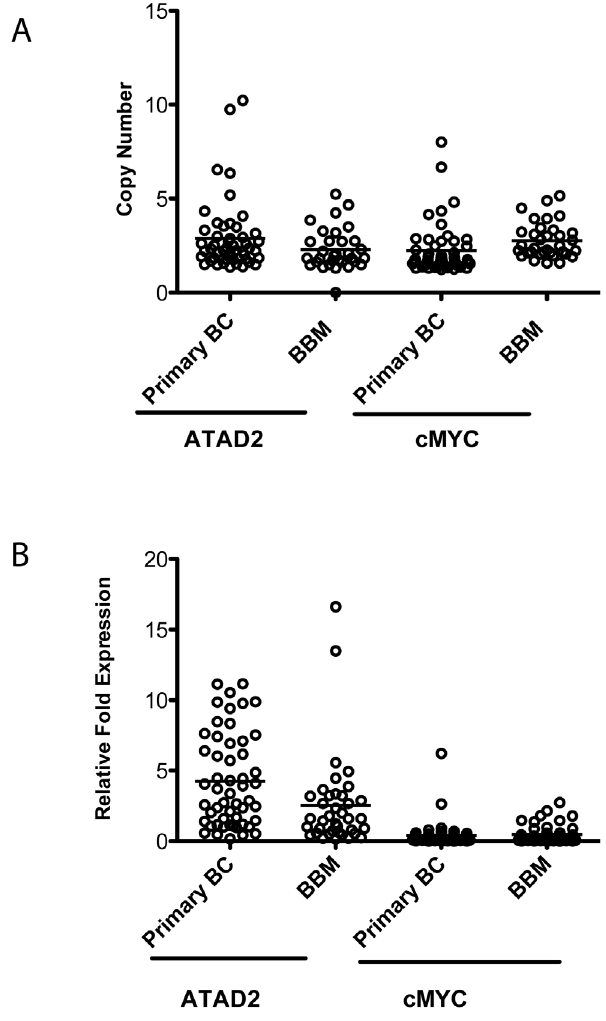
Figure 5. Validation of ATAD2 and cMYC Copy Number and Gene Expression in Breast Brain Metastasis (BBM, n=42) and Early-Stage Primary Breast Cancer Samples (n=50). A) Vertical scatter plots demonstrate a copy number gain of ATAD2 and cMYC by qPCR but with no difference between BBM and primary breast tumors. B) Vertical scatter plots show comparative overexpression of ATAD2 in both primary tumors and primary breast cancer, whereas cMYC is not expressed. None of the comparisons between primary tumors and BBM samples were statistically significant ( p . 0.05).